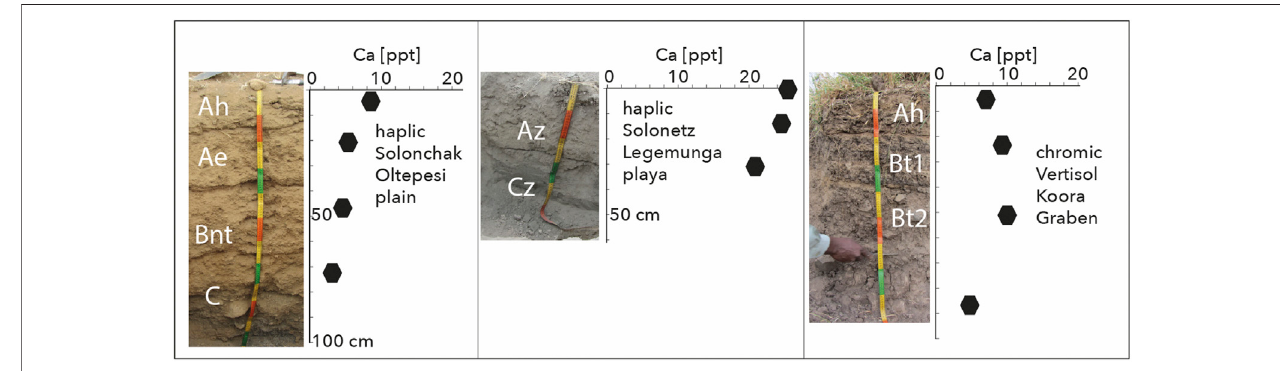
FIGURE7| Soilpro fi lesandCavariationswithdepth; (A) haplicSolonchakfromsoilpitonOltepesiplain; (B) haplicSolonetzexhibitingstrongsalini fi cationfeatures from soil pit on Legemunge playa north of Olorgesailie site; (C) chromic Vertisol from road cut in fl oodplain deposits of the Koora graben, SW of Mt. Olorgesailie.